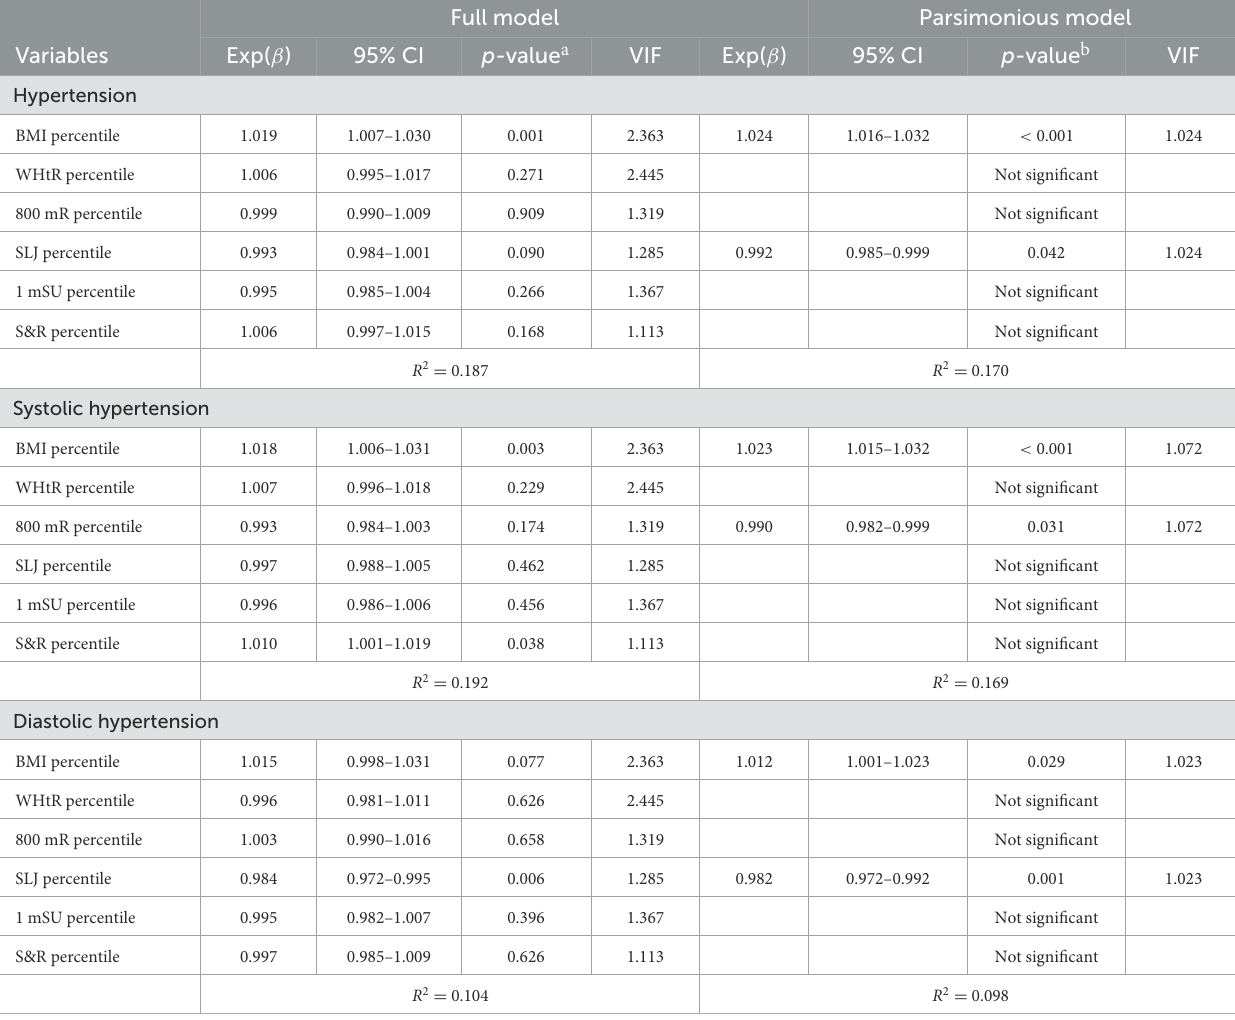
TABLE 4 Independent predictors for pediatric hypertension with anthropometric and physical fitness measures in the overall